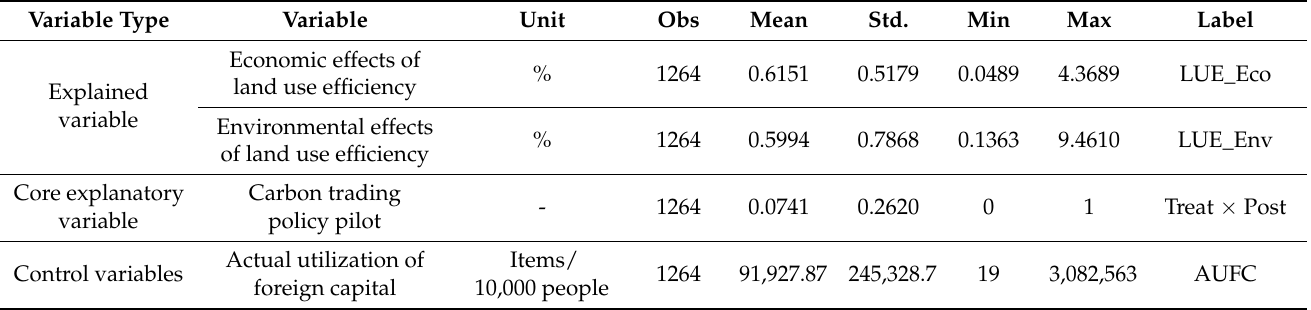
Table 2. Variable